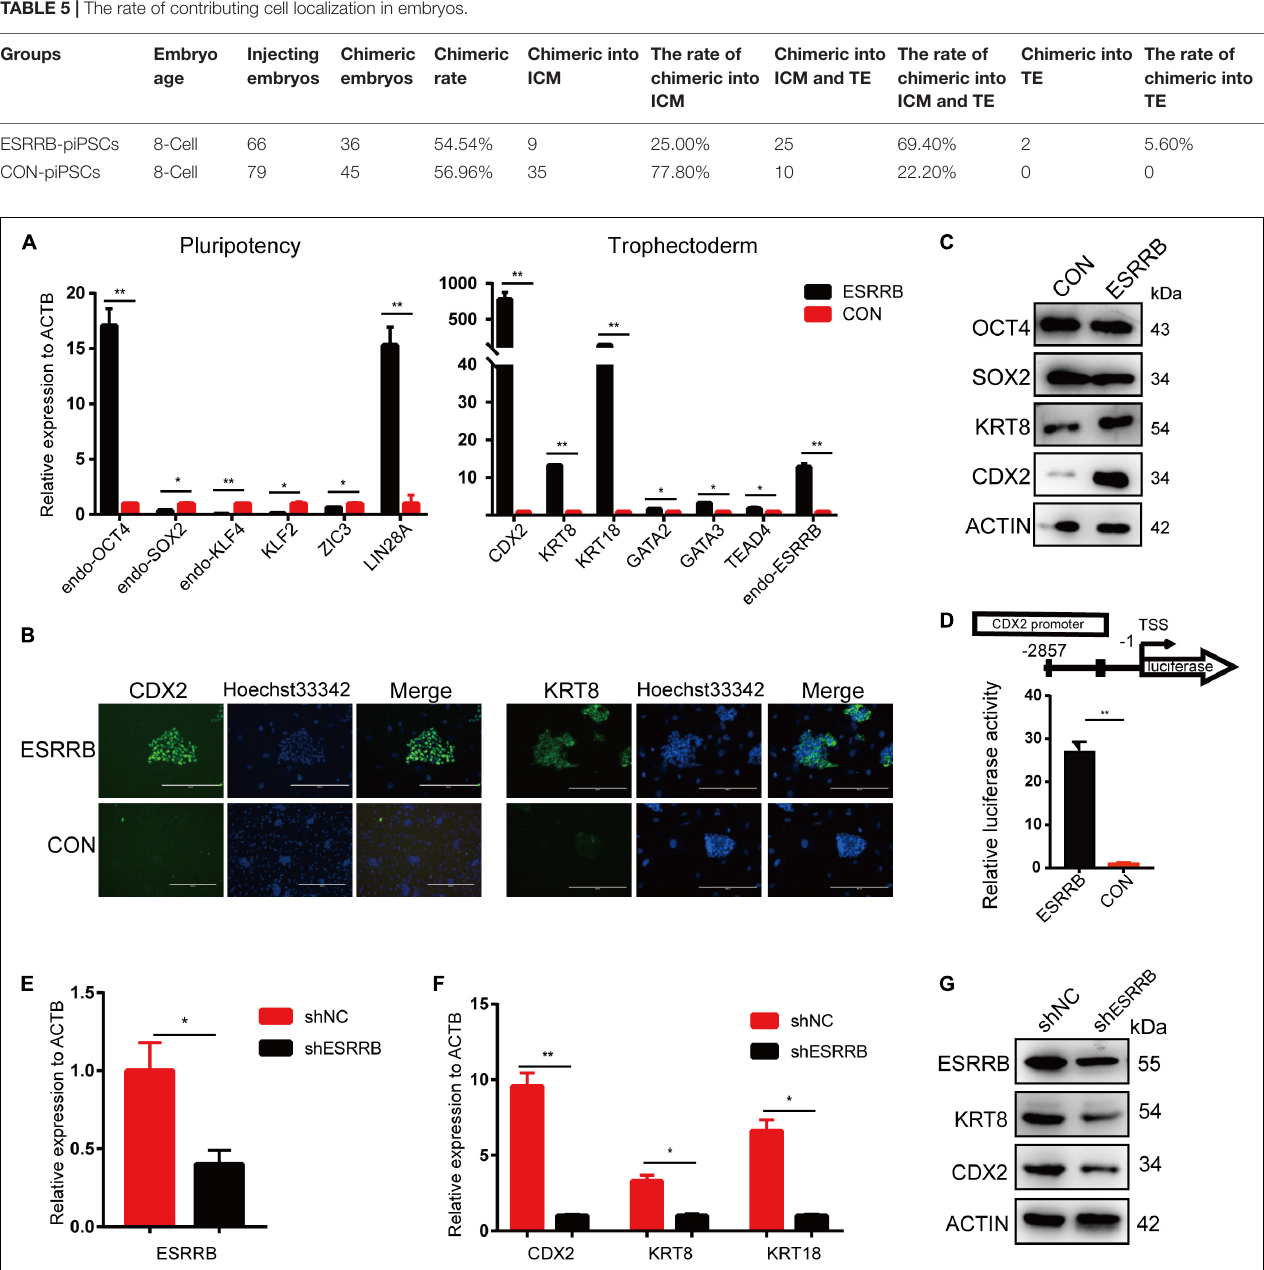
FIGURE 3 | CDX2 was the direct target of ESRRB. (A) qRT-PCR analysis of the expressions of the pluripotent stem cell (PSC) and trophoblast (TSC) markers in the CON- and ESRRB-piPSCs. * p < 0.05 and ** p < 0.001. (B) Immunofluorescence analysis of CDX2 and KRT8 in the ESRRB-piPSCs. The scale bar represents 200 µ m. (C) Western blot analysis of OCT4, SOX2, KRT8, and CDX2 of the CON- and ESRRB-piPSCs. (D) Promoter-luciferase assays for the CDX2-binding region of ESRRB and negative control (NC). NC, empty vector. Data are from three biological replicates and are shown as the mean ± SEM. ** p < 0.001. (E) qRT-PCR analysis of the expression of ESRRB after ESRRB knockdown in the ESRRB-piPSCs. * p < 0.05. (F) qRT-PCR analysis of the expressions of CDX2 , KRT8 , and KRT18 after ESRRB knockdown in the ESRRB-piPSCs. * p < 0.05. (G) Western blot analysis of the expression of ESRRB, CDX2, and KRT8 in the ESRRB piPSCs after ESRRB